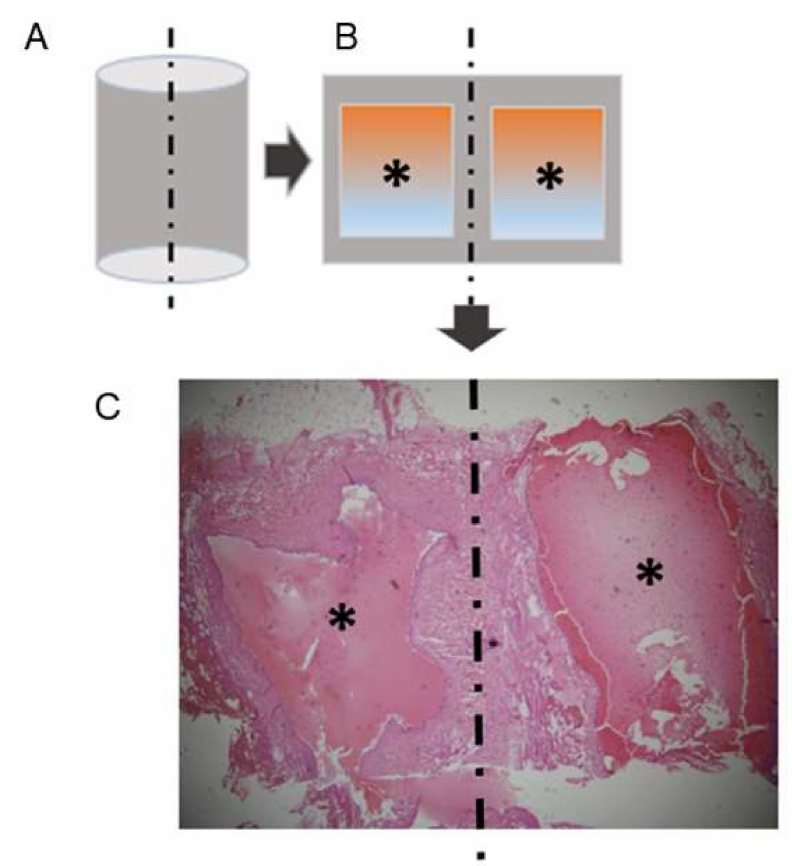
Figure 4. Pathological findings of a damaged thoracic duct. * Amorphous proteinaceous material (iopamidol) in the damaged thoracic duct. Amorphous proteinaceous material is stained red with hematoxylin and eosin stain, but it looks like a liquid rather than a cell. The thoracic duct is a long cylindrical tube; the image shows the collected cylindrical thoracic duct cut along the vertical plane and observed under a microscope. ( A ) represents the cylindrical shape of a thoracic duct and ( B ) represents the shape of a thoracic duct cut along the vertical plane. ( C ) The micrograph shows the left and right parts of a thoracic duct cut along the vertical plane. (hematoxylin and eosin stain, × 12.5) (Group A #2